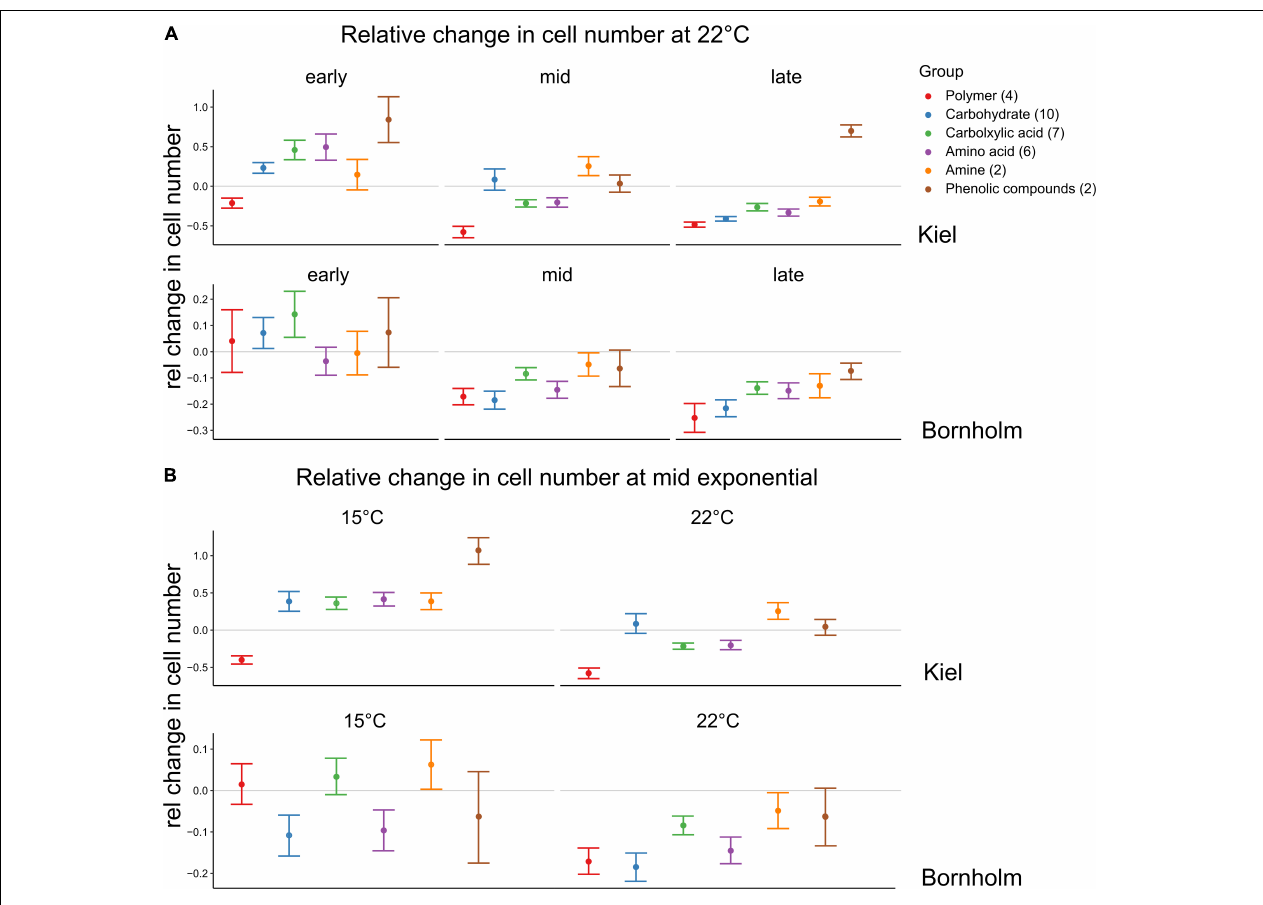
FIGURE 5 | Relative change in cell numbers on the different carbon compound groups. The colors code for the different groups of carbon sources each source belongs to and on which we did the statistical analysis. Shown here are mean ± 1 SE for each group. However, each group contains different numbers of carbon sources (number in brackets) and a total of triplicate/source measurements of 4 or 2 strains for Kiel and Bornholm samples, respectively. A negative relative change indicates that the cells could not profit from being incubated on an organic carbon source whereas the positive change indicated a positive effect of the organic compound. (A) Shows the changes at 22 ◦ C at the different time points whereas (B) shows the changes in mid exponential phase between 15 and 22 ◦